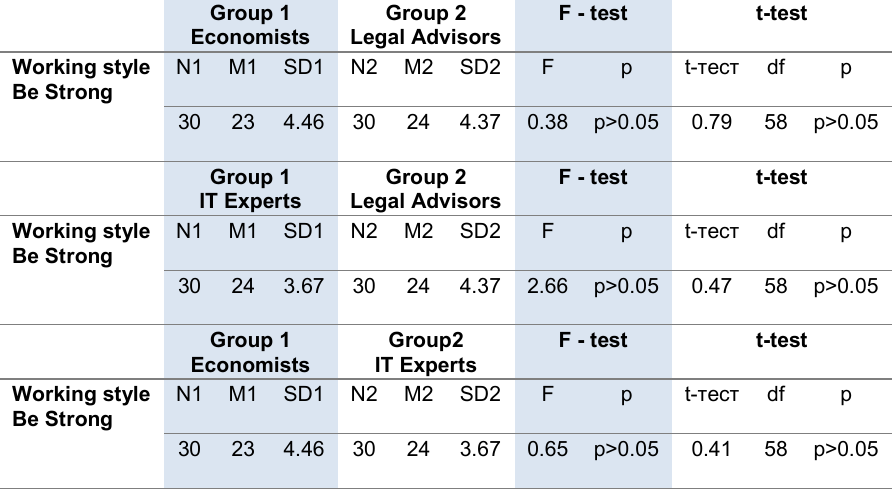
Table 7: Analysis of the differences between the three professions regarding the working style Be Strong Group 1 Group 2 Economists Legal